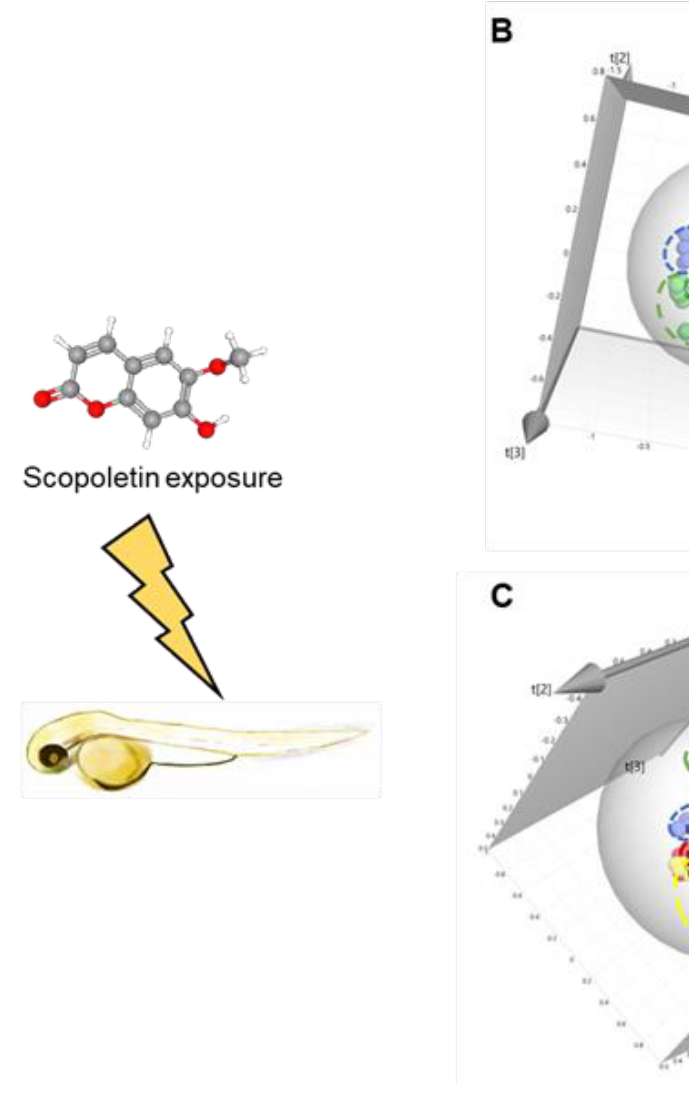
Figure 1. ( A ) Schematic chemical structure of scopoletin exposure. ( B ) 3D PCA score plot based on the UHPLC-MS/MS analysis in negative mode. ( C ) 3D PCA score plot based on the UHPLC-MS/MS analysis in positive mode. In the PCA model, green points represent the fish water control group, blue points represent the solvent control group, red points represent the 1/9 MNLC of the scopoletin-treated group, yellow points represent the 1/3 MNLC of scopoletin-treated group, baby-blue points represent the MNLC of scopoletin-treated group, and purple points represent the QC group.